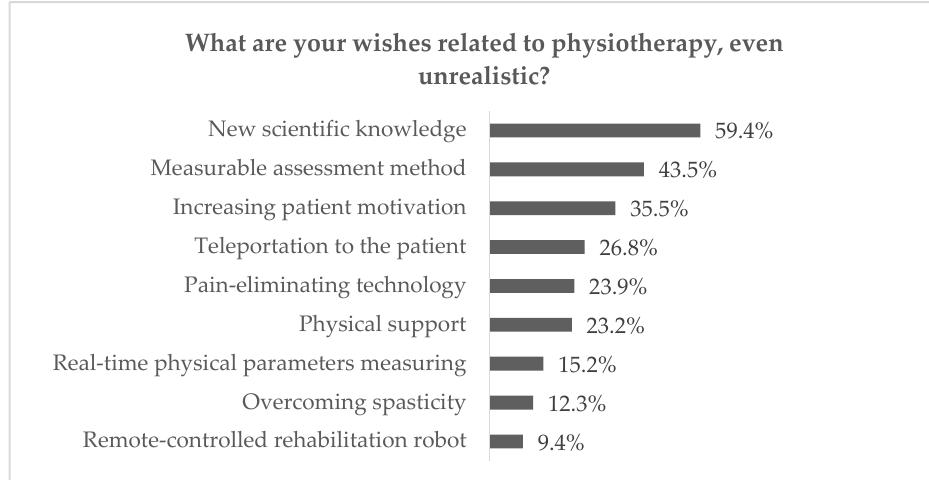
Figure 1. Answers to question 1 from questionnaire research.